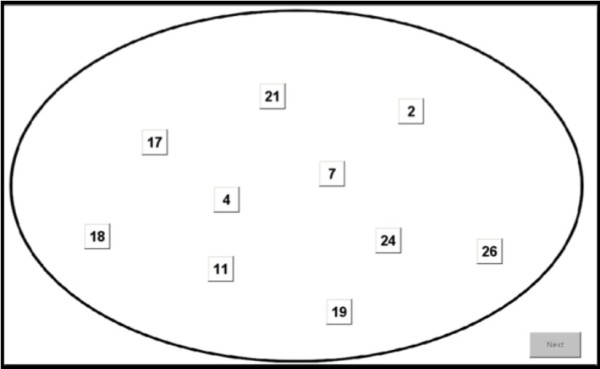
An example number trial on the computerised mCST. Having clicked on all numbers in either ascending (numerical) or descending (reverse numerical) order (depending on the instruction presented to the participant on the screen before trial 1) the participant had to click on the Next button to move on to the next trial (in this case, letters). Following trial 4 a new instruction would be shown on the screen (to complete the task in the opposite order to the one on trial 1-4) and subsequently trials 5-8 would be shown.